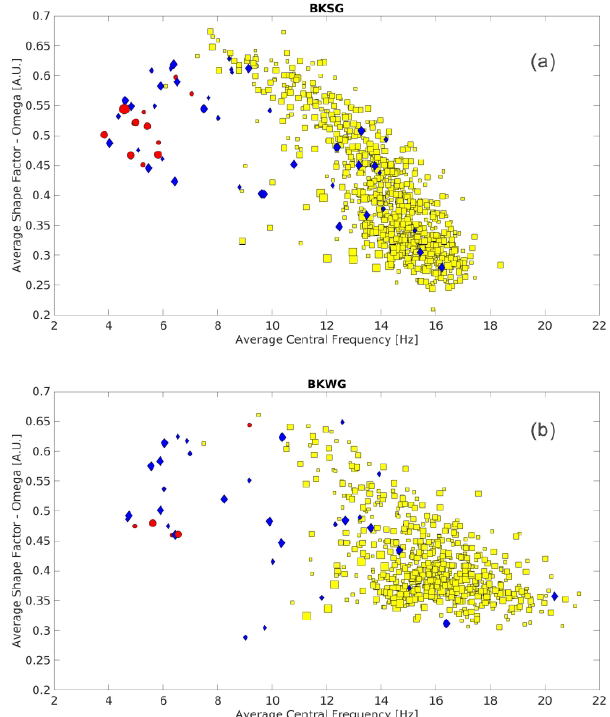
Figure 4. Average shape factor vs central frequency evaluated for BKSG (a) and BKWG (b) stations. LF events, unclassified events and VT earthquakes are shown with red circles, blue diamonds and yellow squares, respectively. The size of symbol is indicative of the signals maximum amplitude in ground velocity. The visualized re- sults are obtained by averaging on the three components of motion.